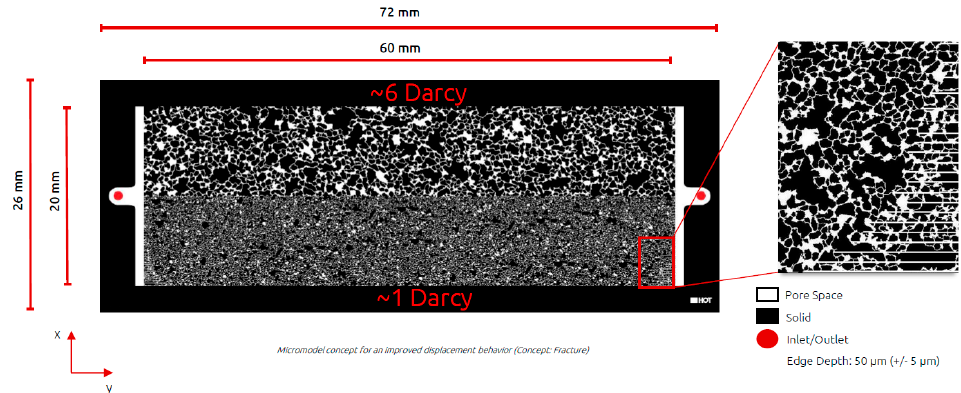
Figure 1. Design, and structure of the heterogeneous micromodel used for the experiments. The “high permeability” layer (upper) had permeability of about 6 Darcy, while “low” permeability layer (lower) had permeability of 1.5 Darcy. The structure is based on a Bentheimer pores, and the lines observed in the zoomed images (right) were used to ensure connectivity of the pores to the inlet/outlet.